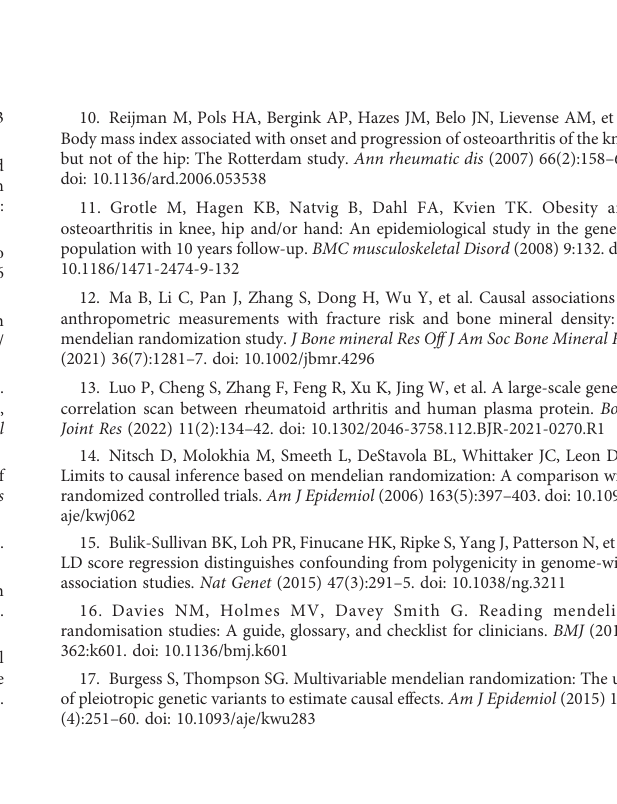
SUPPLEMENTARY TABLE 6 Results of the conditional F-statistics in multivariable MR. SUPPLEMENTARY TABLE 7 Results of mediation